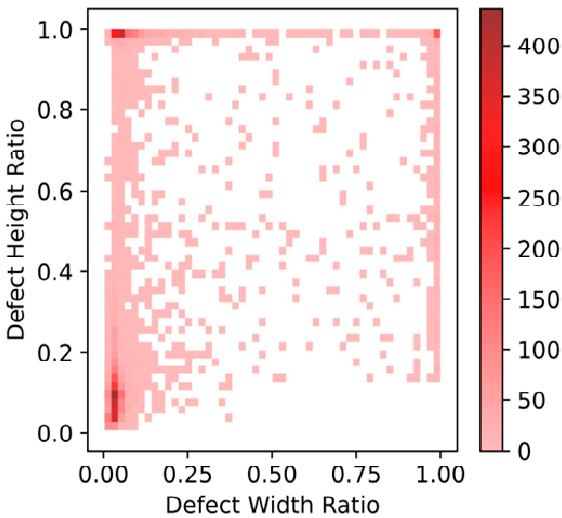
Figure 9. Proportion of defect size.